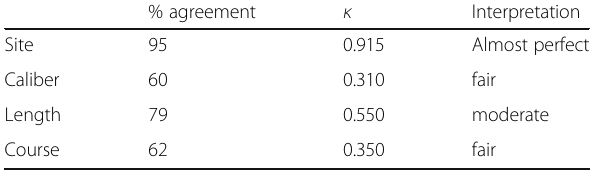
Table 3 Agreement between P-CTA and CDUS in the detection of the deep inferior epigastric artery perforator; site in relation to the umbilicus, caliber of perforator as it pierces the rectus abdominis, and course of the intramuscular segment %